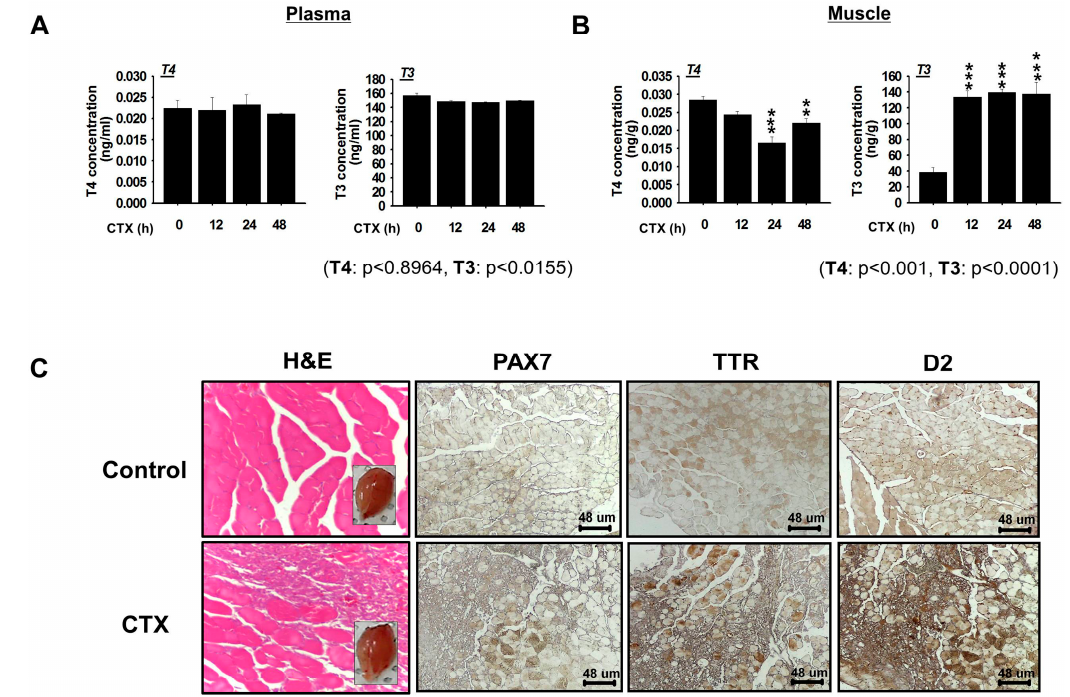
Figure 1. Relationships between muscle injury and thyroid hormone (T3 and free T4) concentrations. Tissue and plasma samples of mice subjected to cardiotoxin (CTX) injection were analyzed for the expressions of TTR and of the thyroid hormones, T3 and free T4. ( A , B ) Estimation of the concentrations of free T4 and T3 at early time points in plasma and muscle samples by ELISA. Concentrations of T3 and free T4 are measured as amounts (pg or ng) per gram of muscle tissue; ( C ) Transverse section of muscles after Hematoxylin–Eosin (H&E, 400 × ) and immunostaining with PAX7, TTR, or deiodinase 2 (D2) antibodies. The upper and bottom panel show non-injected (control) and CTX injected muscle, respectively. p -values indicate statistical significance of the data (mean ± S.D., n = 3, **: p < 0.001, ***: p < 0.0001).